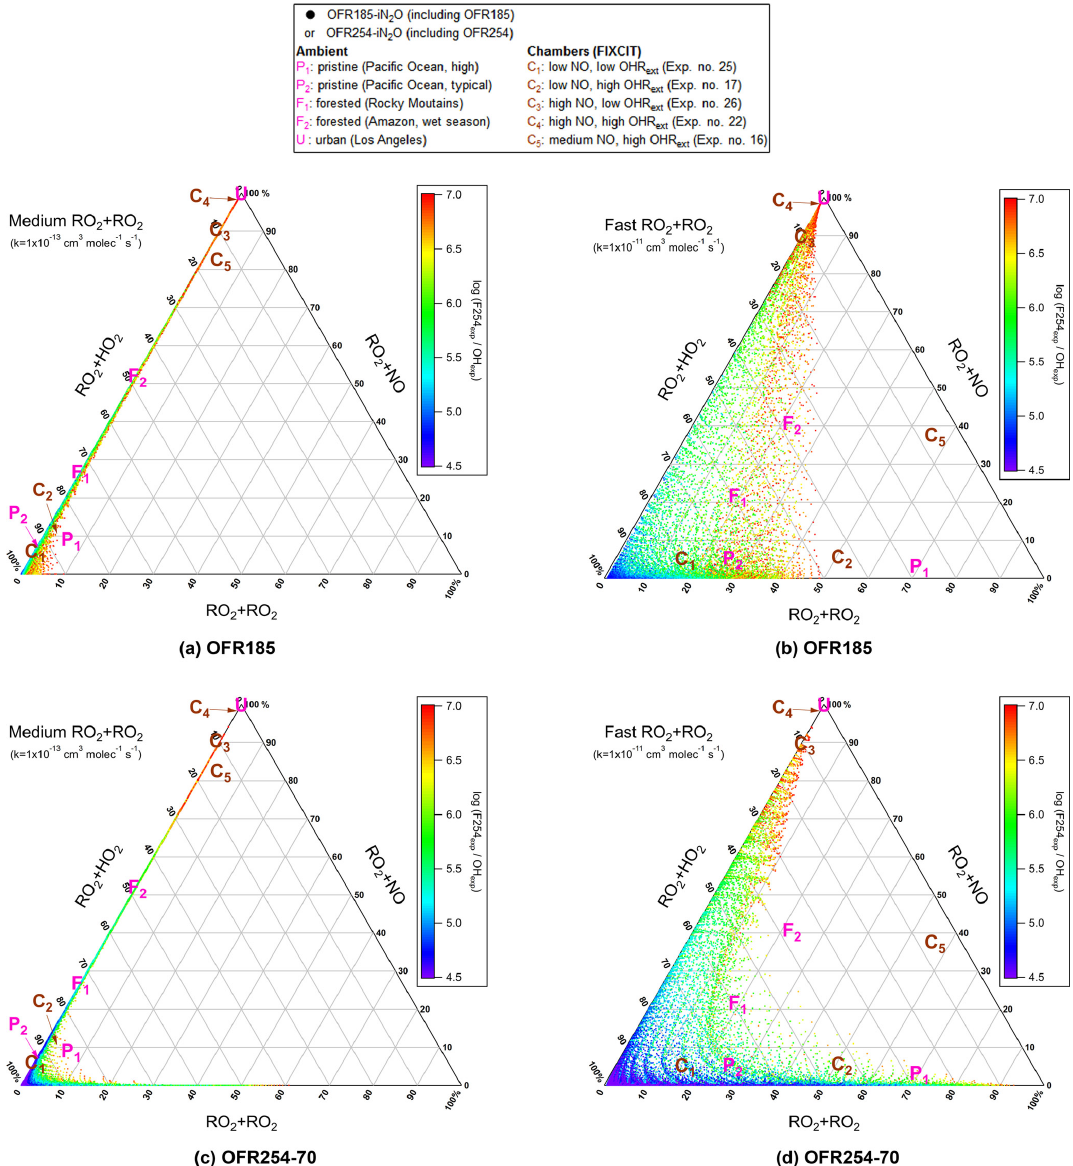
Figure 1. Triangle plots of RO 2 fate by RO 2 + HO 2 , RO 2 + RO 2 and RO 2 + NO (without RO 2 + OH and RO 2 isomerization considered in the model) for RO 2 with the medium self- and cross-reaction rate constant (1 × 10 − 13 cm − 3 molecule − 1 s − 1 ) in (a) OFR185 (including OFR185-iN 2 O) and (c) OFR254-70 (including OFR254-70-iN 2 O) and for RO2 with the fast self- and cross-reaction rate constant (1 × 10 − 11 cm − 3 molecule − 1 s − 1 ) in (b) OFR185 (including OFR185-iN 2 O) and (d) OFR254-70 (including OFR254-70-iN 2 O). Inclined tick values on an axis indicate the grid lines that should be followed (in parallel to the inclination) to read the corresponding values on this axis. The OFR data points are colored by the logarithm of the exposure ratio between 254nm photon flux and OH, a measure of badness of OFR conditions in terms of 254nm organic photolysis. Several typical ambient and chamber cases (see Table 2 for details on these cases) are also shown for